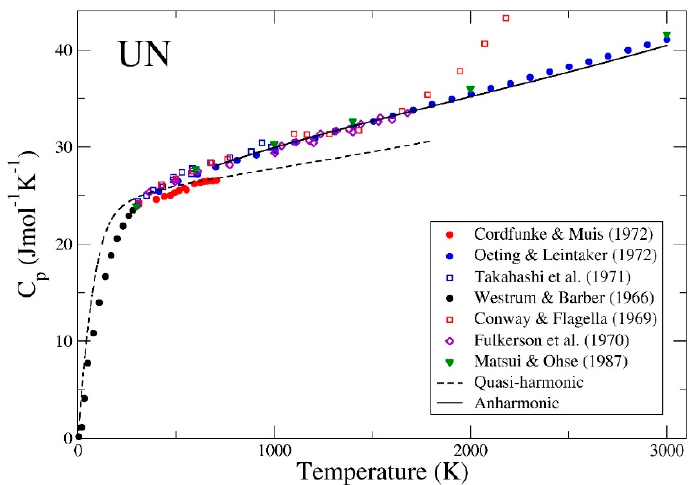
Figure 3. Theoretical models for the heat capacity at ambient pressure, assuming quasi-harmonic and anharmonic phonons. The experimental data are collected from References [4,7,8,12,13,15,19]. Note, the heat capacity is calculated per gram-atom (g-at.) of N 2 and 1 mol of N 2 , which is equivalent to 1 gram-molecule of N 2 , contains 2 gram-atoms of N 2 .